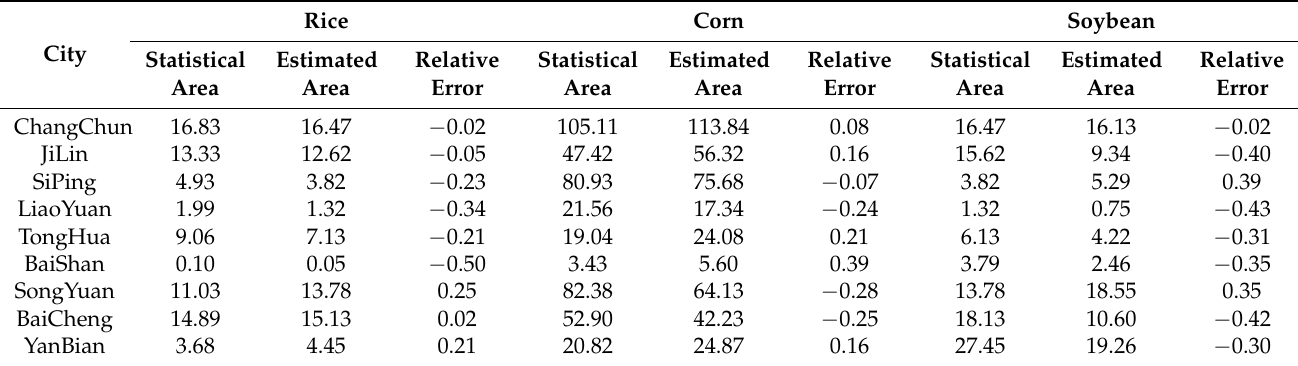
Table 3. Relative error of crop extraction results in 2015 (10 4 ha).